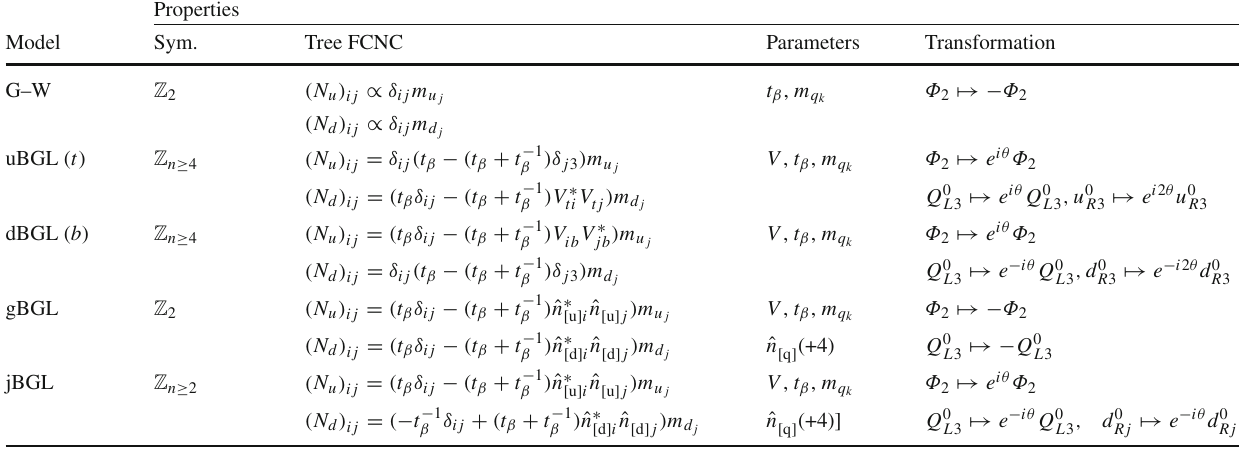
Table 2 Models obeying the Left conditions of Eq.(18). For the uBGL and dBGL models we only show the FCNC corresponding to one case, the top and bottom models, respectively. The first row shows